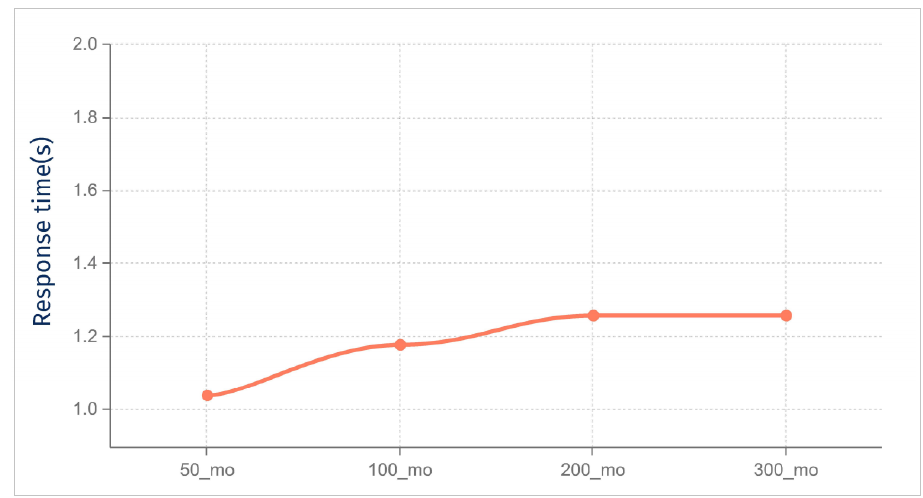
Figure 8. Impact of number of moving objects in building on system